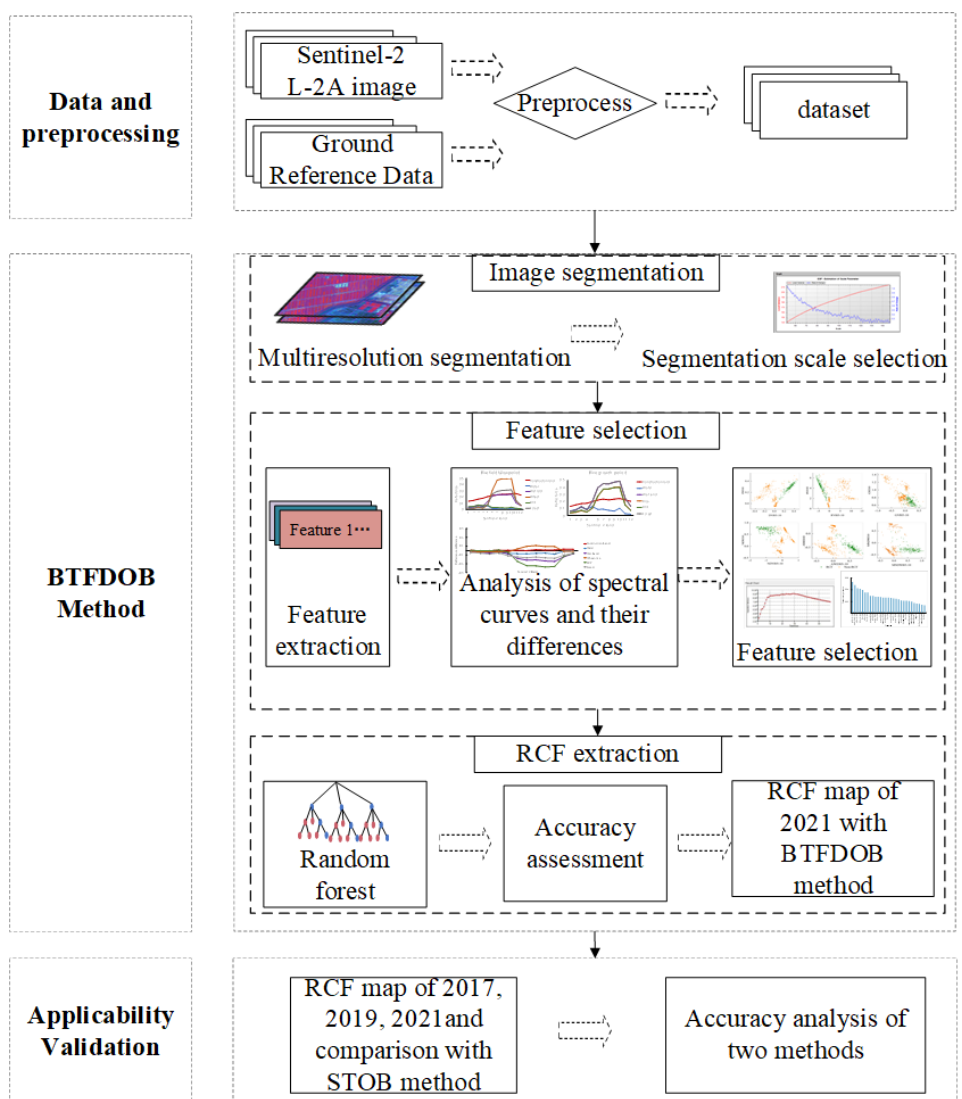
Figure 2. The workflow of the